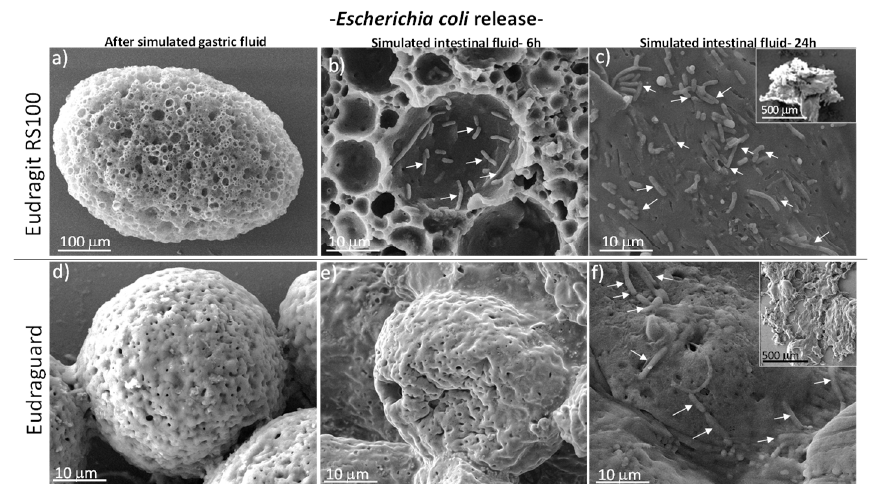
Figure 6. SEM micrographs of Eudragit RS 100 ( a – c ) and Eudraguard ( d – f ) microparticles loaded with Escherichia coli and immersed in simulated gastric ( a , d ) and intestinal fluids ( b , c , e , f ). White arrows depict the location of bacteria.